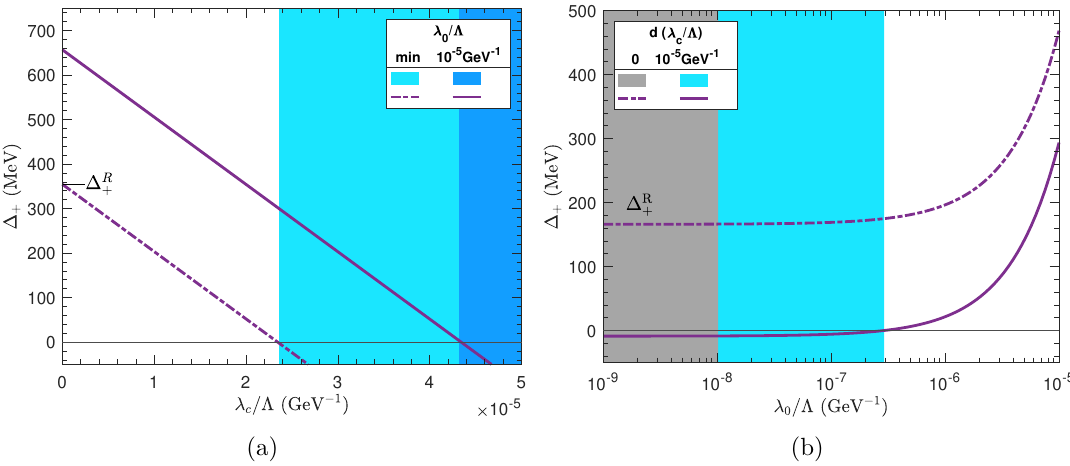
Figure 2. Left 2(a): mass splitting of the highest weight state χ + with respect to λ c / Λ coupling in the pseudo-real doublet model. The neutral coefficient is fixed to its minimum, value of ( λ 0 / Λ) min = 10 − 8 GeV − 1 and also λ 0 / Λ = 10 − 5 GeV − 1 for solid and dashed-dotted lines respectively. The light (dark) blue region is excluded at minimum ( 10 − 5 GeV − 1 ) due to the requirement (2.22) for DM χ 0 to be the lightest particle. Right 2(b): mass difference of the χ + field as a function of λ 0 / Λ coupling. The dashed-dotted line correspond to the average strength of ( λ c / Λ) av = 1 . 2 × 10 − 5 GeV − 1 , and solid line corresponds to the deviation d λ c / Λ = 1 . 2 × 10 − 5 GeV − 1 . The grey patch is ruled out as a result of the direct detection constraint (2.28). The light blue area is excluded since χ + becomes heavier than DM candidate, according to